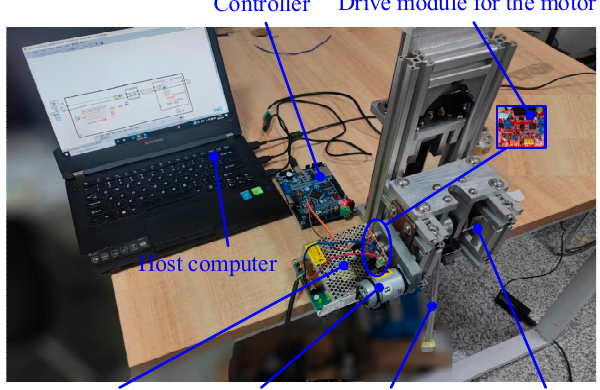
Figure 11. Experimental platform for variable stiffness actuator.